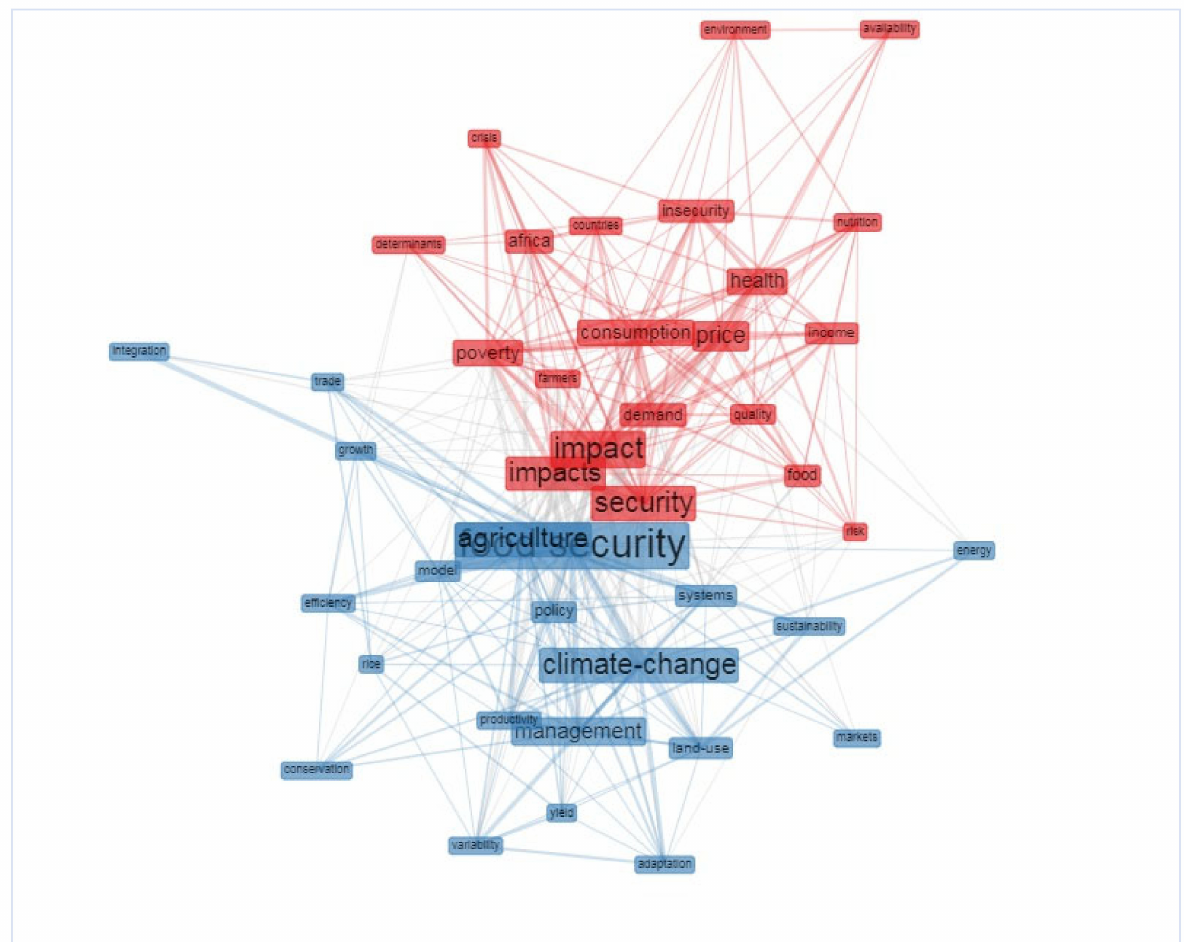
Figure 5. Keywords co-occurrence analysis. Source R: studio results.